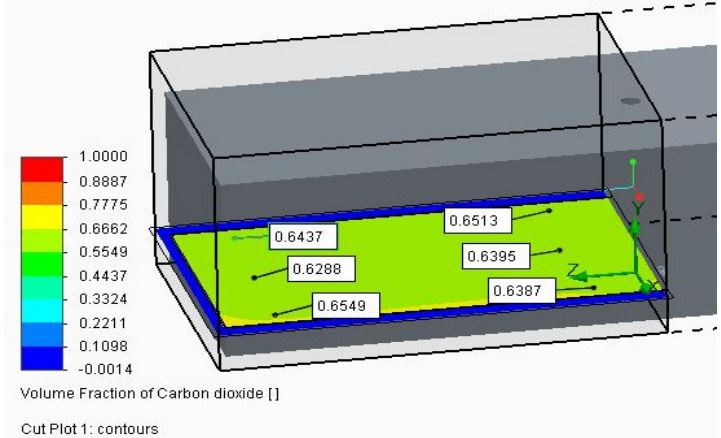
Figure 3. A horizontal cut plane at 25 cm above the floor showing the CFD CO concentrations at the same locations used in Figure 2 at one time constant (5 min). The uniform color indicates the uniform carbon dioxide volume